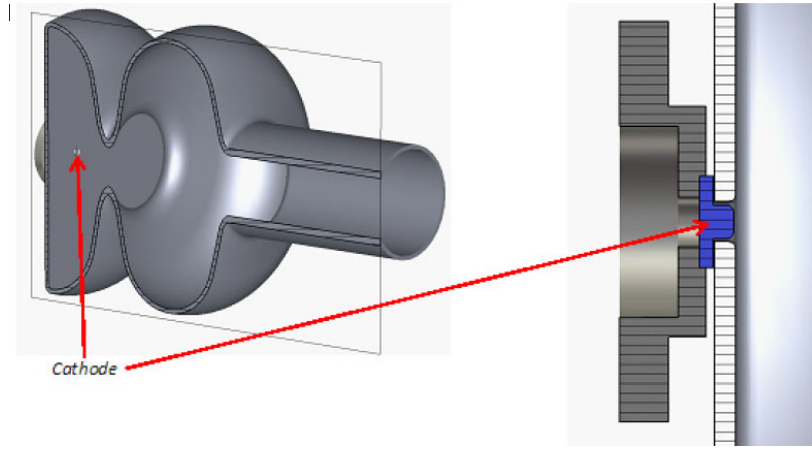
Figure 3. Design of Jlab/RadiaBeam SRF gun with plasmonic Nb cathode [13].